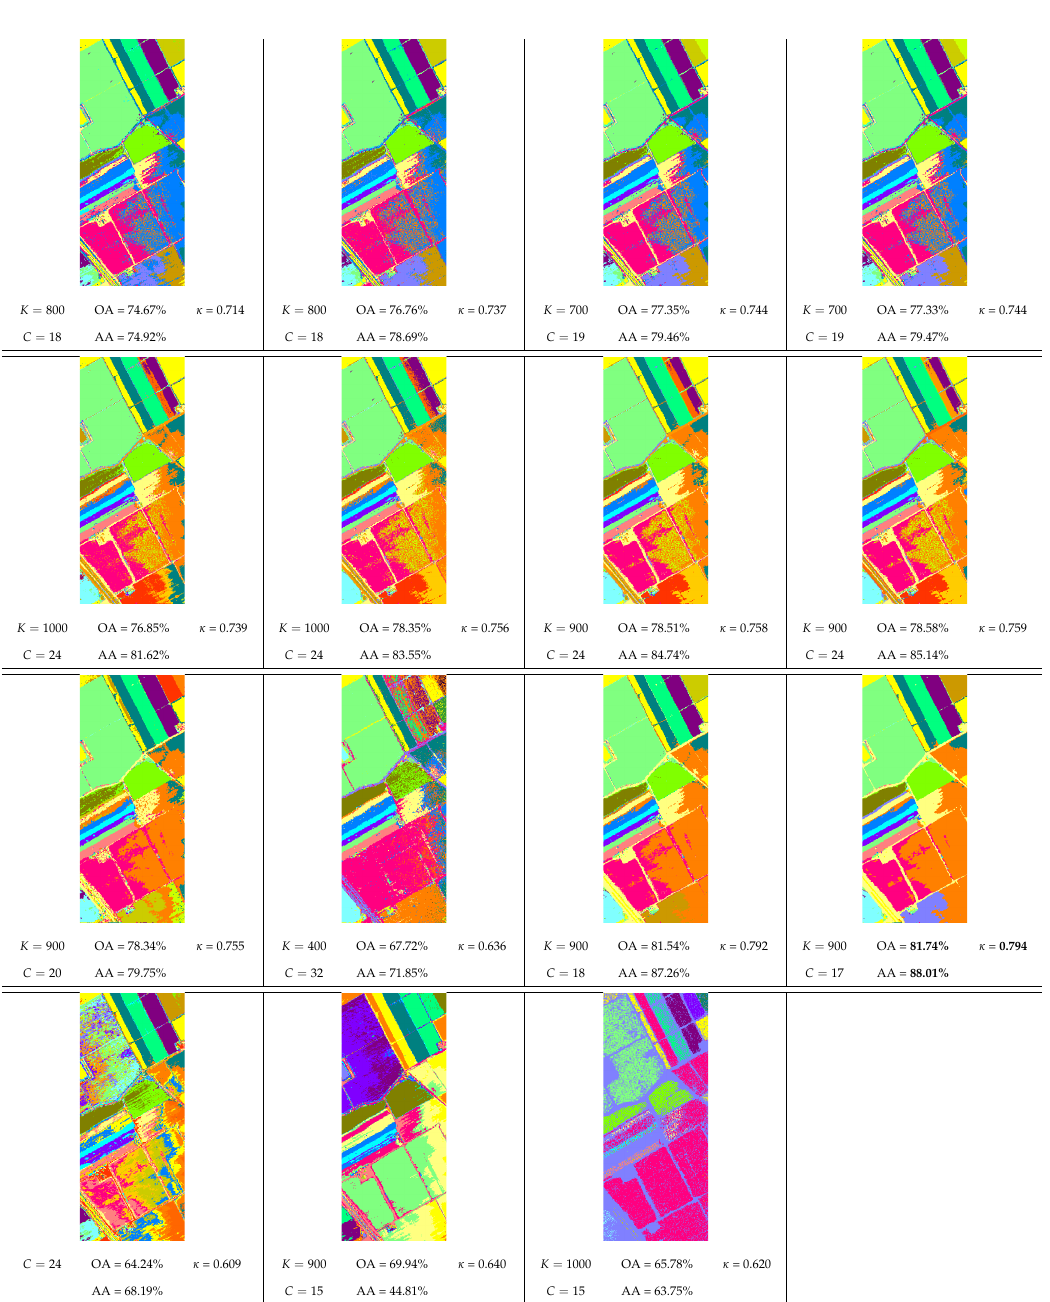
Figure 9. Best clustering maps with regard to kappa index for Salinas HSI with state-of-the-art and proposed methods. First row: baseline methods; second row: with MNN; yhird row: with MNN and spatial context; from first to fourth column, respectively: MODESEEK , M - KNN - DPC , GWENN - WM , M - KNNCLUST - WM . Fourth row, from left to right: FCM ; FSAP ; DBSCAN